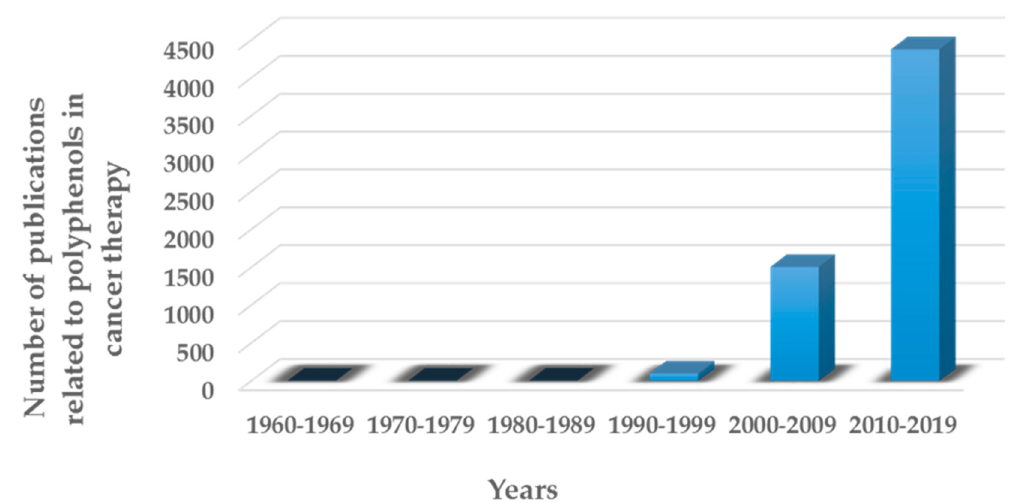
Figure 2. Number of peer-reviewed articles published in the last decades in the field of polyphenols in cancer therapy.